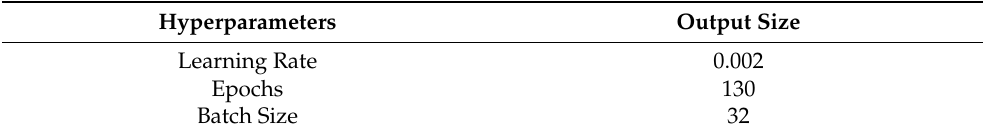
Table 3. Definition of hyperparameters for the